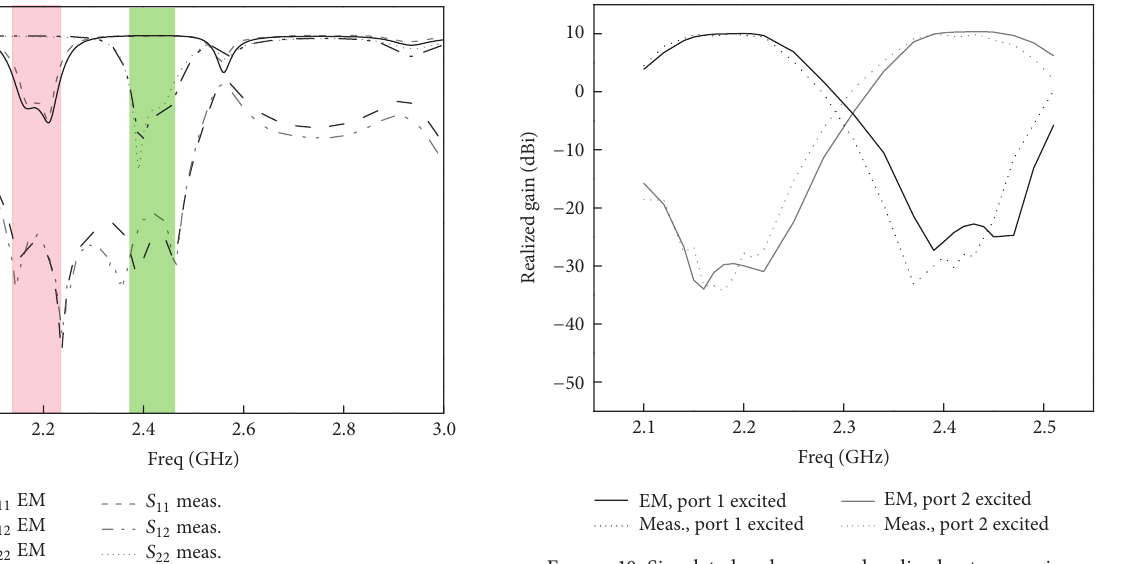
Figure 9: Simulated and measured 𝑆 -parameter of the antenna array.